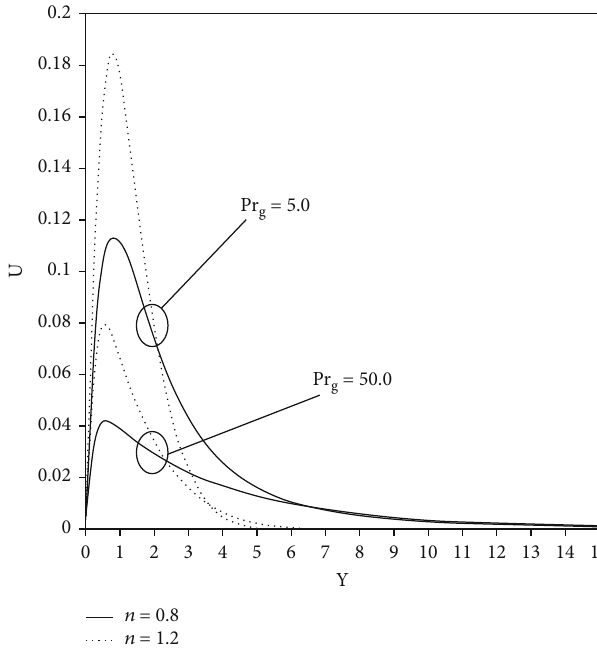
Figure 8: Velocity pro fi le for α = 0 : 1 , Br = 0 : 5 , n = 1 : 2 -0.8, and Q = 0